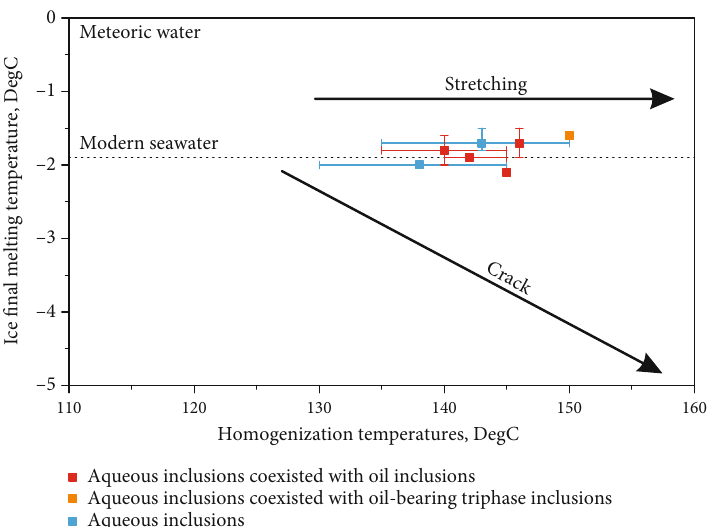
Figure 6: Relationships between ice-melting temperatures ( T